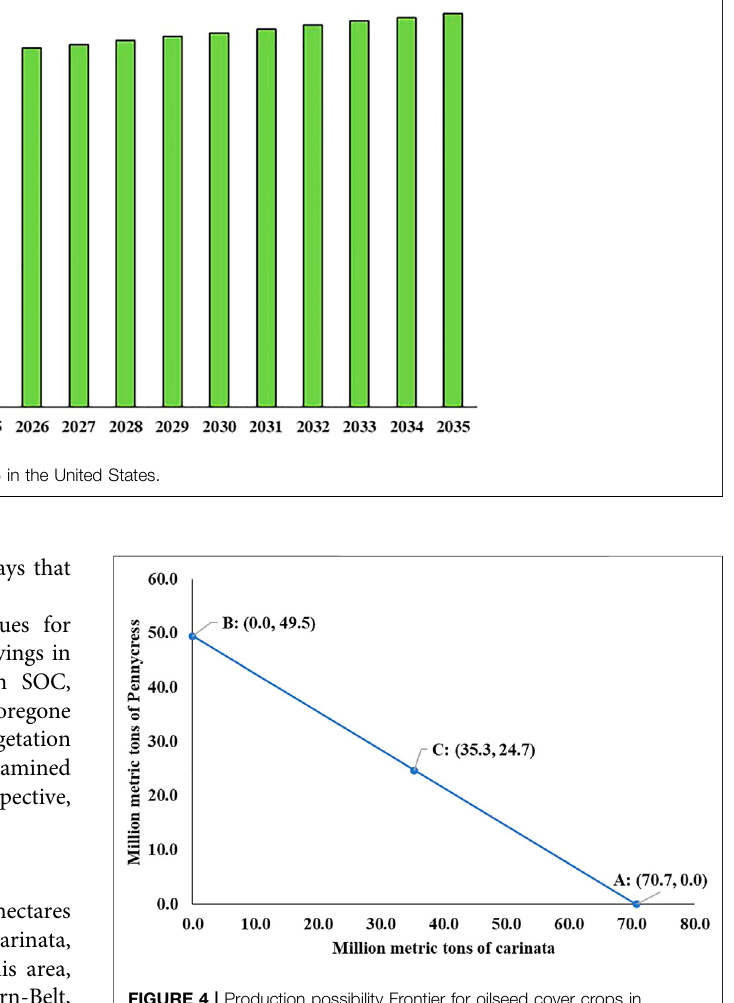
FIGURE 4 | Production possibility Frontier for oilseed cover crops in 2035 in the United